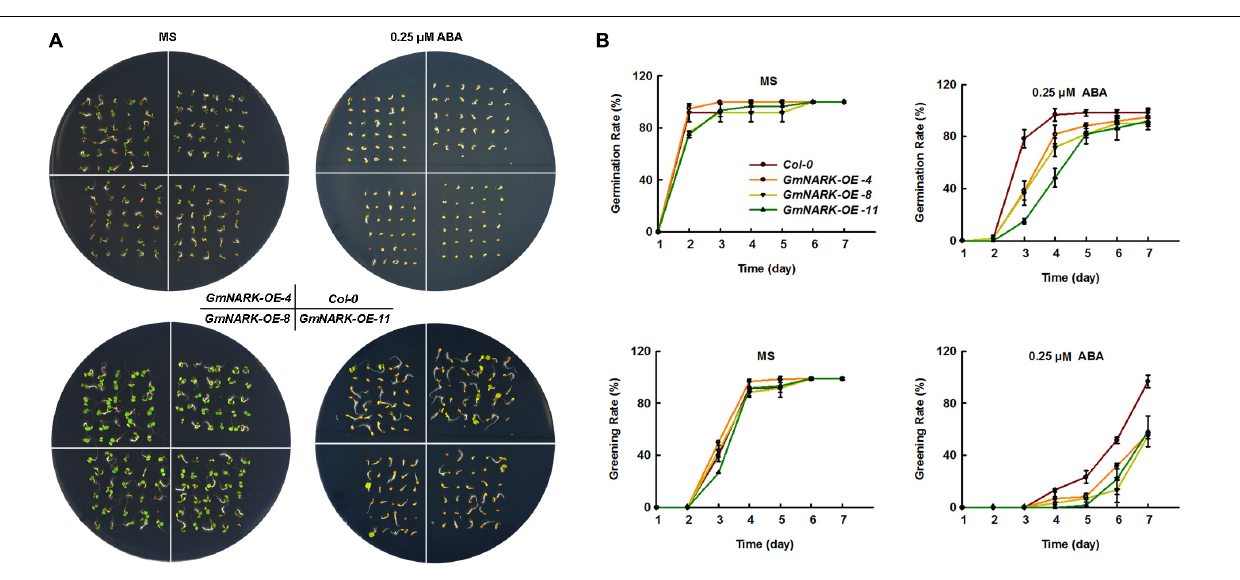
FIGURE 8 | Overexpression of GmNARK increased transgenic Arabidopsis sensitivity to ABA during germination and greening. (A) Phenotypic analysis of Col-0 , GmNARK-OE-4 , GmNARK-OE-8 and GmNARK-OE-11 treated with 0.25 µ M ABA. The up panel is the germination images of 3-day-old seeds and the bottom panel is the greening images of 5-day-old seeds. (B) The germination rates and greening rates of Col-0 , GmNARK-OE-4 , GmNARK-OE-8, and GmNARK-OE-11 under 0.25 µ M ABA treatment. The data were given as means plus the standard deviation of three independent